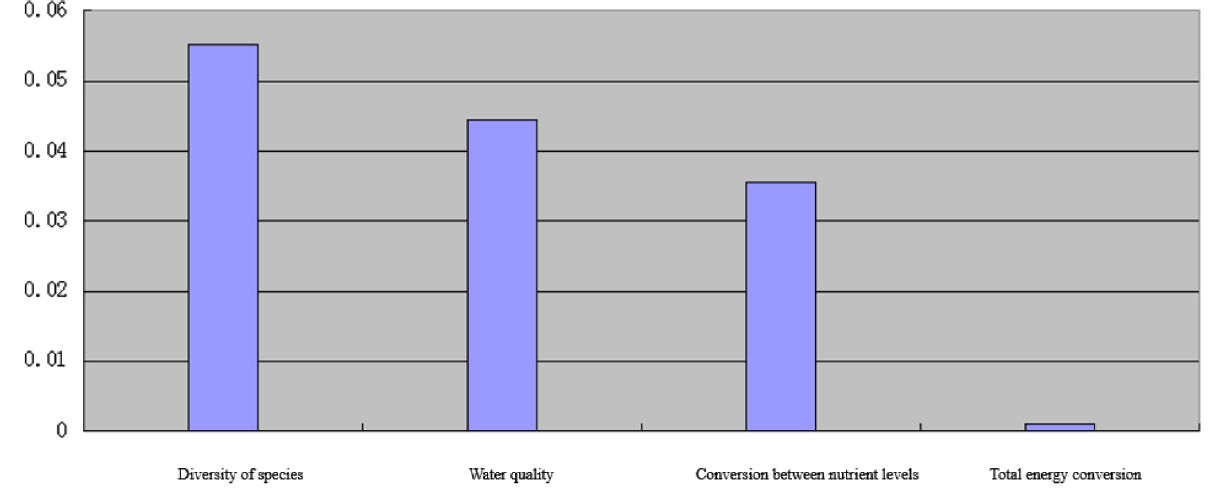
Fig. 5 Comparison diagram of weighted score of each index in the state